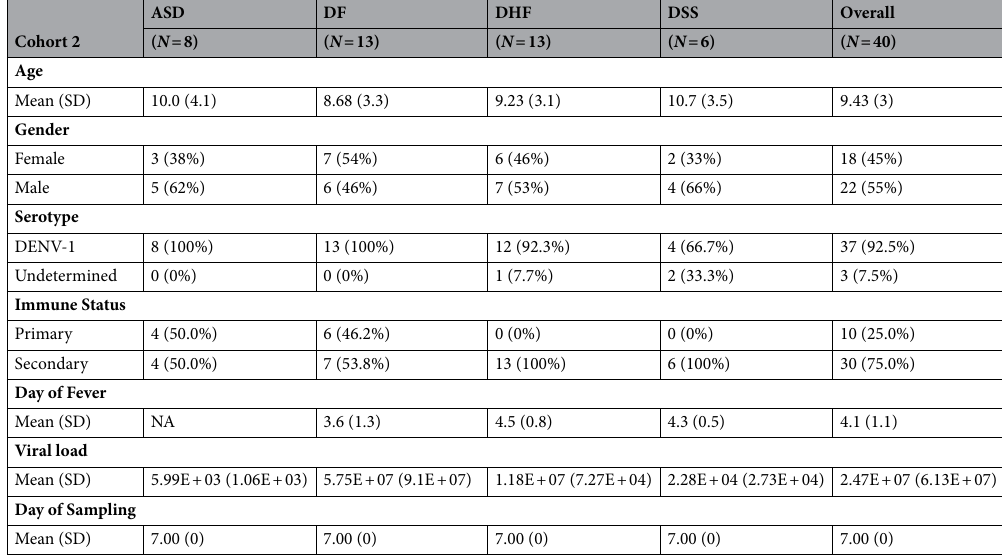
Table 2. Demographic and clinical characteristics of cohort 2. NA: not